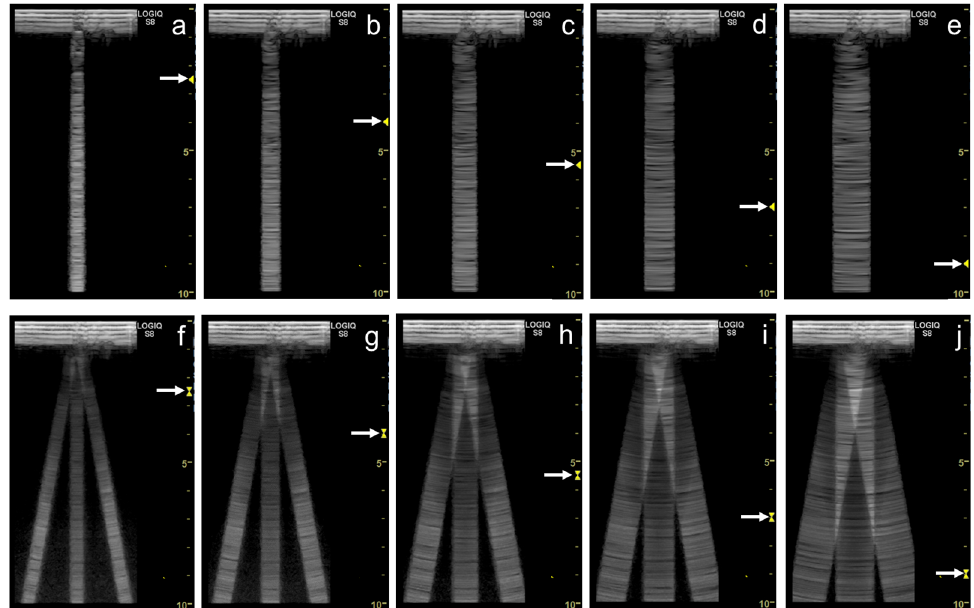
Figure 12. Ultrasound images obtained with the. linear transducer. The vertical artifact becomes wider as the focal point (arrow) is moved to deeper levels ( a – e ). When spatial compound imaging is enabled, the single vertical artifact changes to three lines radiating from the same point ( a , f ). The three lines become wider as the focal point (arrow) is moved to deeper levels ( f – j ).